Question: Name the type of graph shown.
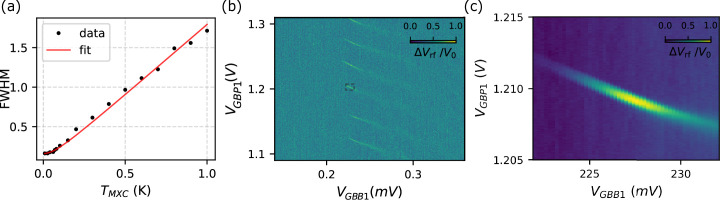
Answer: line